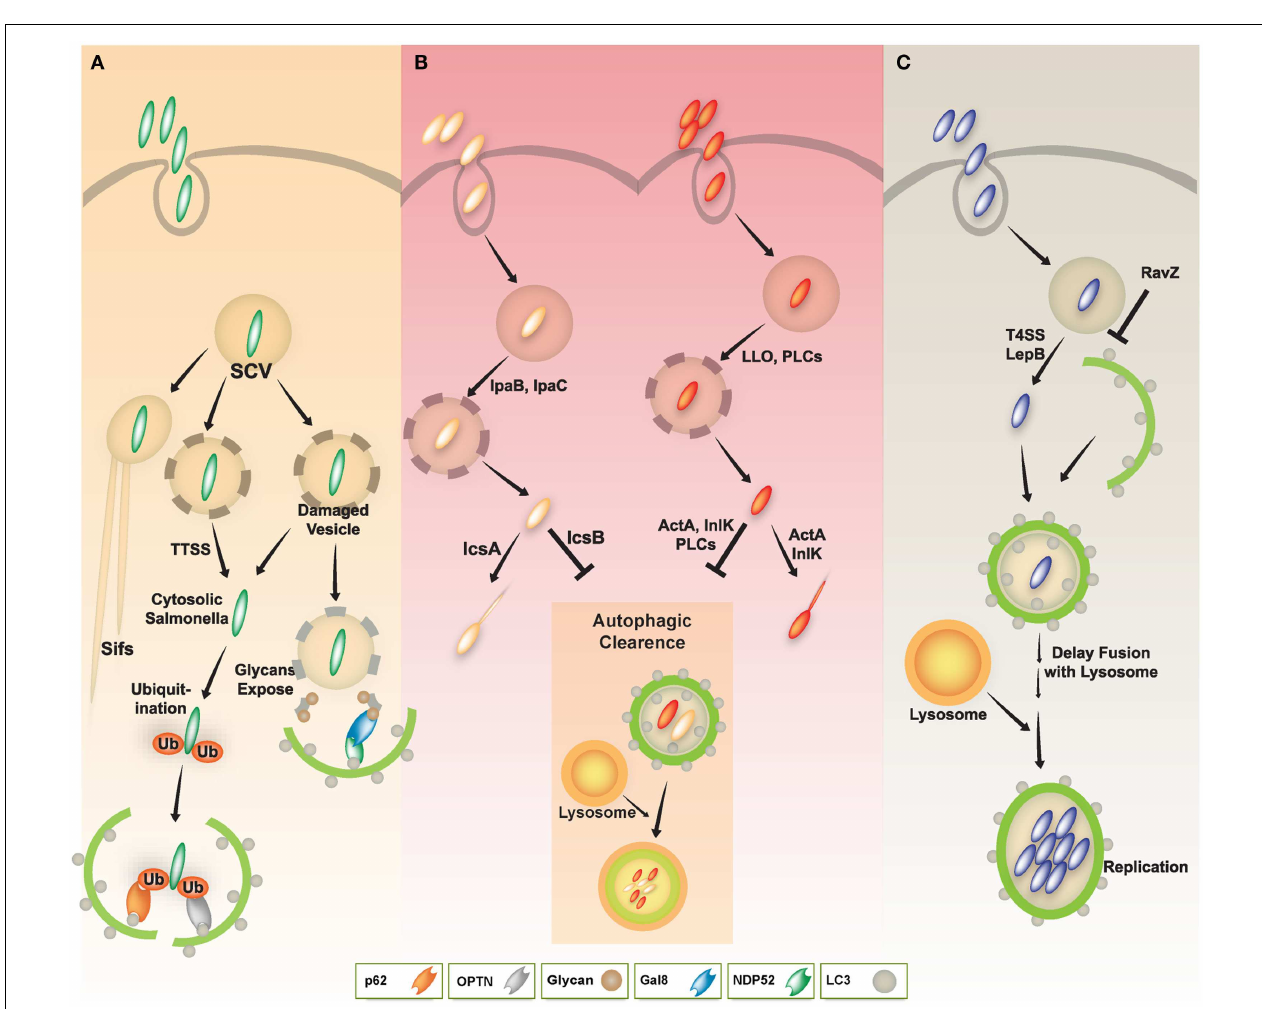
for autophagic degradation. Galectin-8 can detect a wide variety of vesicle-damaging pathogens in addition to Salmonella , e.g., Shigella and Listeria . (B) In Shigella and Listeria infection, the bacteria can escape from vacuoles to the host cytosol via their bacterial products (e.g., IpaB, IpaC, LLO, or PLCs).The cytosolic Shigella and Listeria have actin-based motility, contributing to their escape from autophagy. Essential bacterial products (e.g., IcsA, IcsB, ActA, or InlK) are involved in actin-based motility and inhibition/evasion of autophagy. (C) In Legionella infection, L. pneumophila also escapes from vacuoles to the host cytosol via LepB throughType IV secretion system. Cytosolic L. pneumophila is recognized by its autophagic machinery; however, Legionella delays fusion of the autophagosome with lysosomes until it develops into an acid-resistant form.The acid-resistant Legionella can replicate in the acidic autophagolysosome. Legionella also interferes with autophagy by using its bacterial effector protein